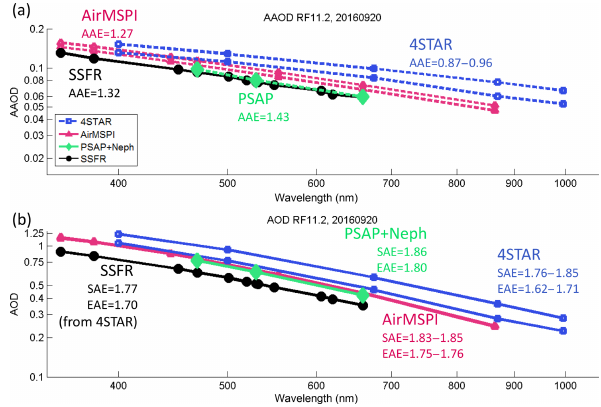
Figure 7. As in Fig. 5, (a) AAOD and (b) AOD versus wave- length (both on log–log scales) for the case on 20 September for 4STAR, AirMSPI, SSFR, and PSAP + neph. The PSAP + neph op- tical depths are calculated from a 100m bin average profile of neph- elometer scattering and PSAP absorption, and integrated over the vertical column. This case had a full profile from 367m to 7.1km (shown) and additional partial profiles which appear in Fig. 6. Note that SSFR uses 4STAR AOD as input; this coincident AOD is la- beled as SSFR for clarity; thus, the differences between these three AOD spectra are due to spatial variability in the total amount of aerosol loading, likely due to variations in plume-top height ( ∼ 5 . 5– 6km) as observed by